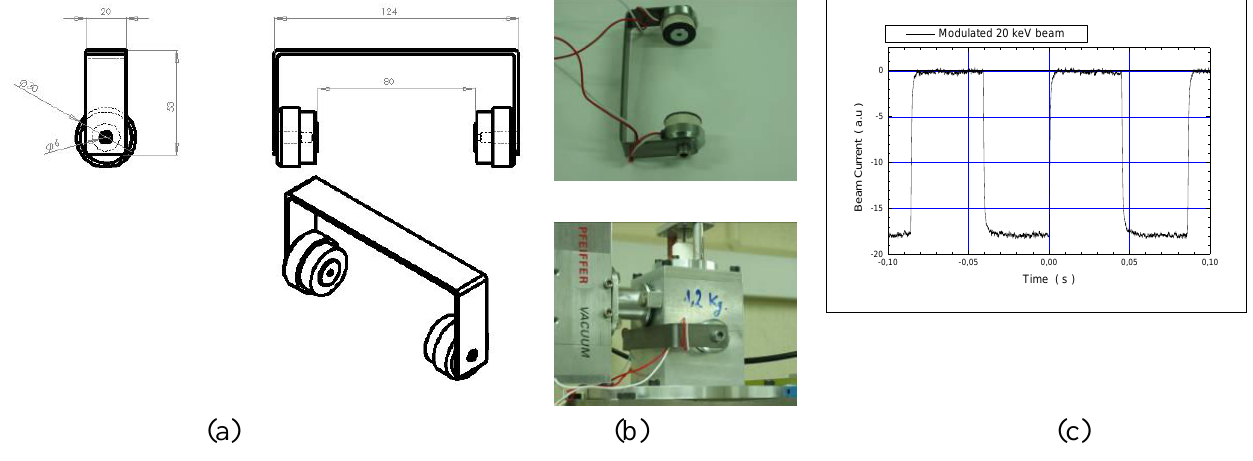
Figure 3. Components and positioning of the magnetic coils for the electron beam deviation system. (a) Design of the magnetic deviation component. (b) Set up on the electron gun. (c) Example of results obtained for the intensity of the beam pulsed with the magnetic